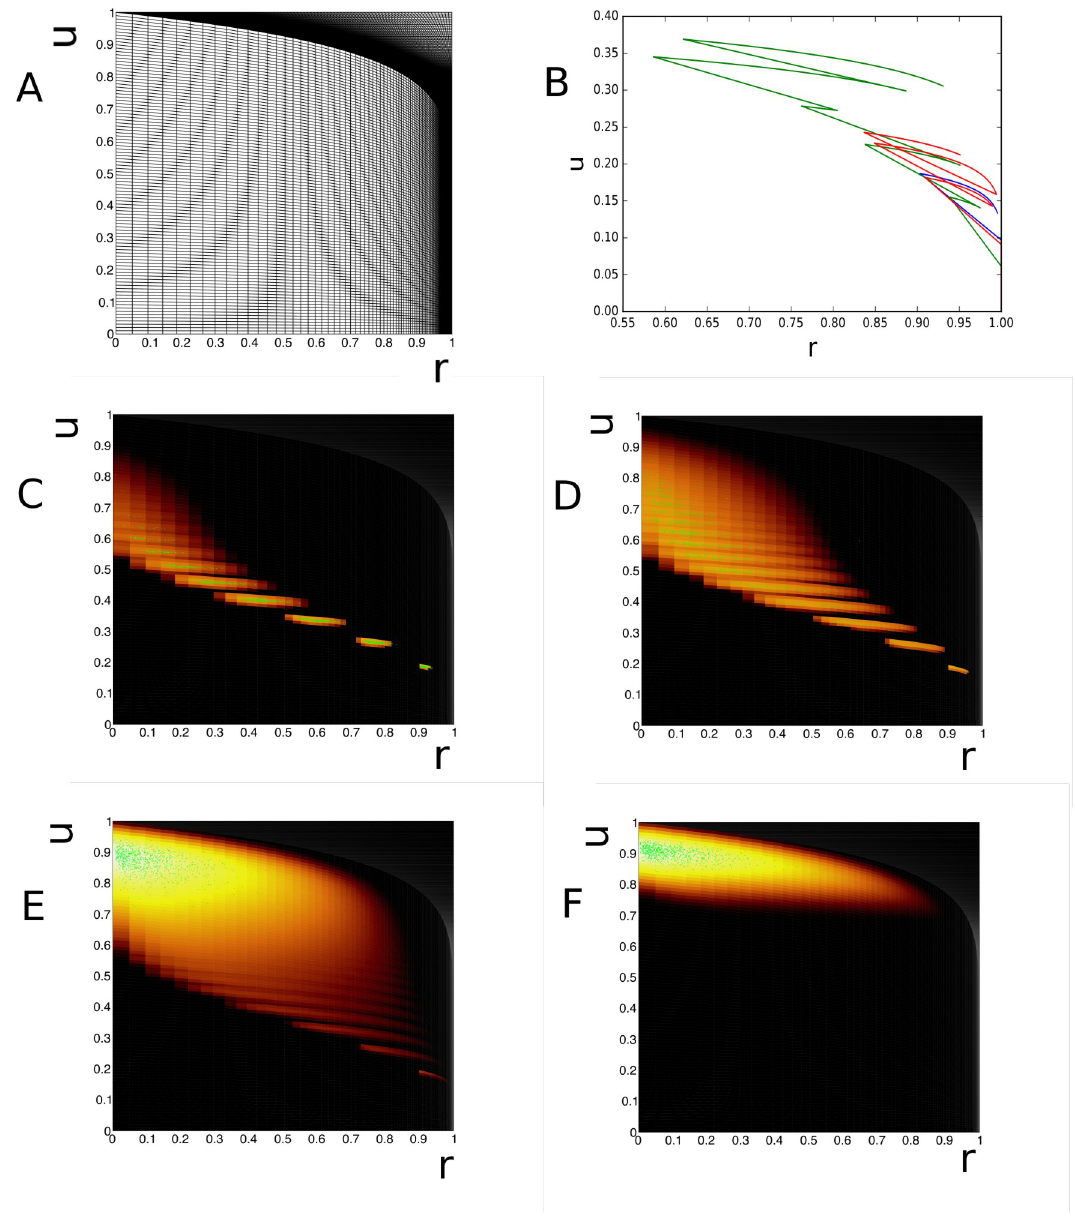
Fig 12. Evolution of the state of a population of facilitating Tsodyks-Markram synapses. A: Grid. B: Sample path of individual synapses. The state dependency of the jump size is clearly visible. C-F: evolution of density over